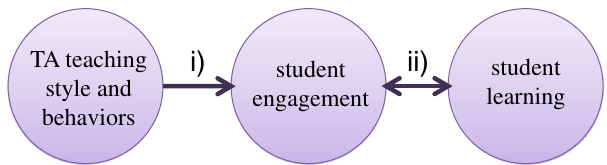
FIG. 3. The main results of our study. We found significant positive correlations (denoted by a solid line) between (i) the frequency of TA – student interactions (a product of TA teaching style and behaviors) and student engagement [ r ð 14 Þ ¼ 0 . 52